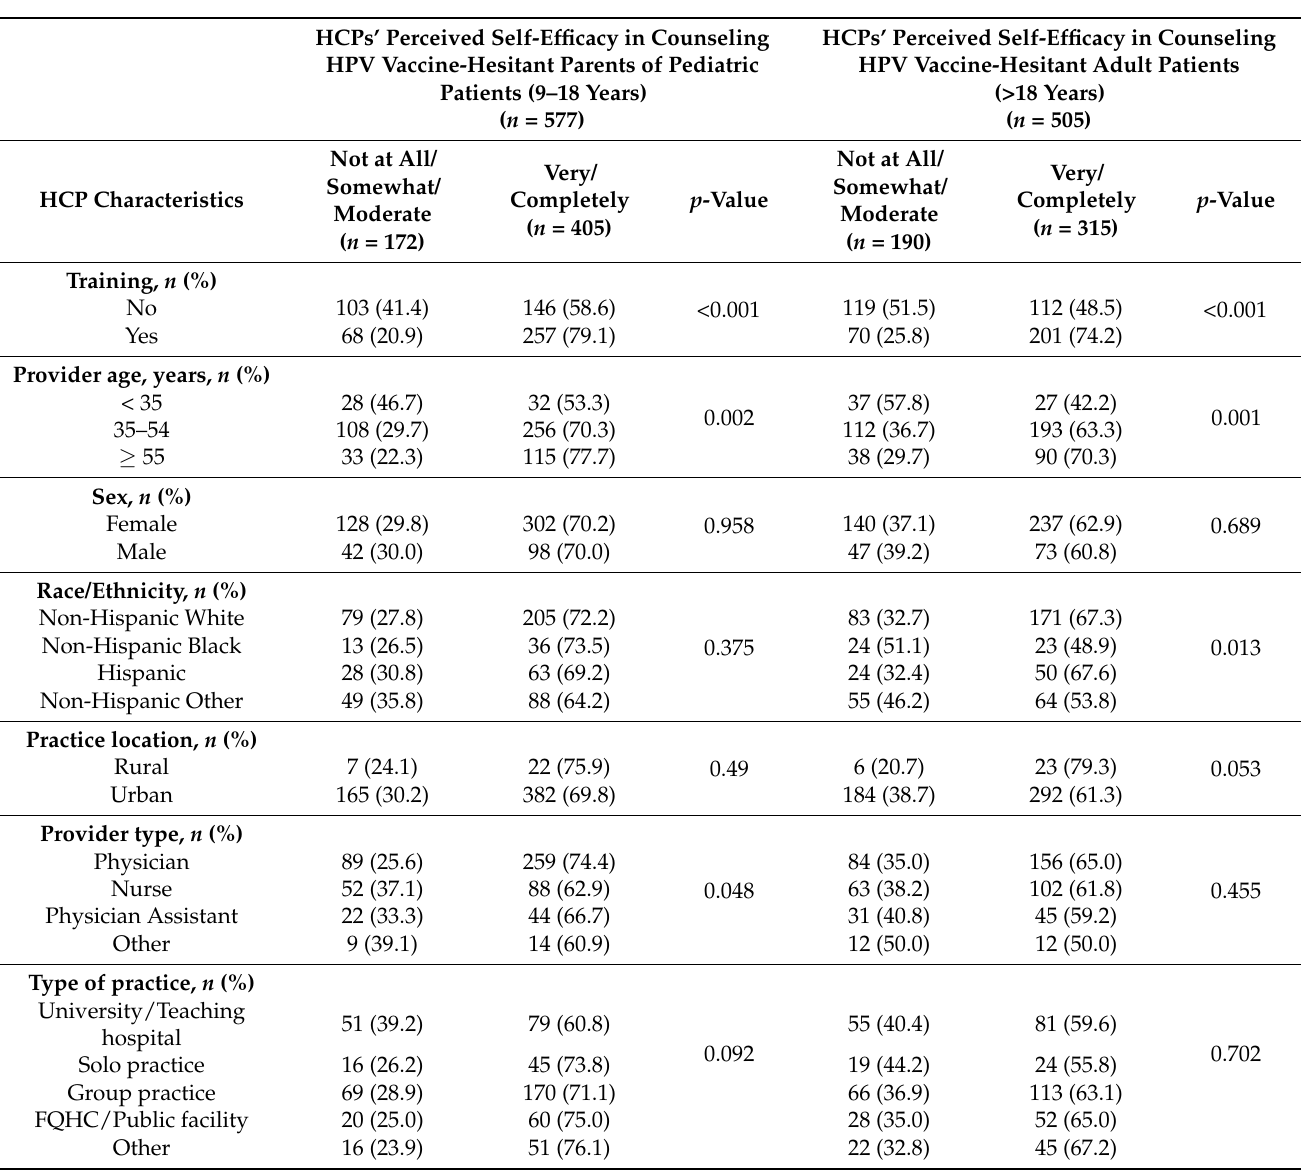
Table 1. Distribution of training, demographics, and practice-related factors for HCPs by strata of HCPs’ perceived self-efficacy in counseling HPV vaccine-hesitant parents of pediatric patients and adult patients. HCPs’ Perceived Self-Efficacy in Counseling HCPs’ Perceived Self-Efficacy in Counseling HPV Vaccine-Hesitant Parents of Pediatric HPV Vaccine-Hesitant Adult Patients Patients (9–18 Years) (>18 Years) ( n = 577) ( n =